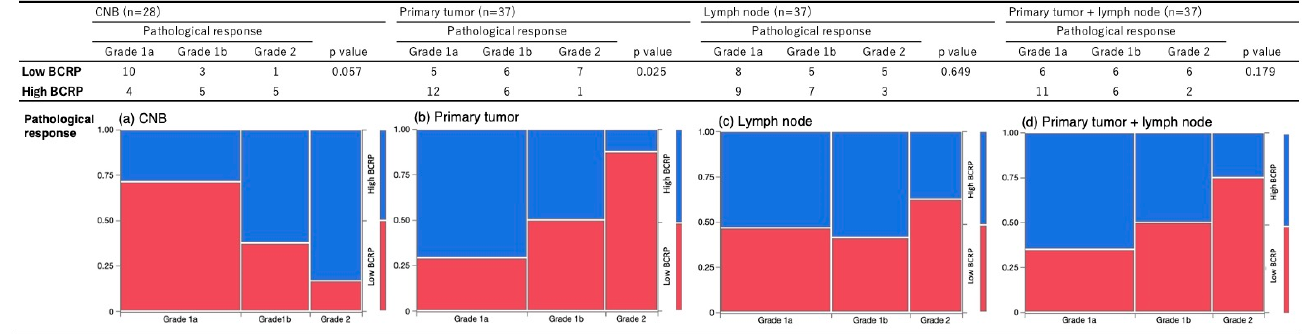
Figure 2. Association between BCRP expression binarized by the median and pathological response in ( a ) CNB, ( b ) primary tumor, ( c ) metastatic lymph node, and ( d ) primary tumor and metastatic lymph node samples; blue, low BCRP; red, high BCRP.